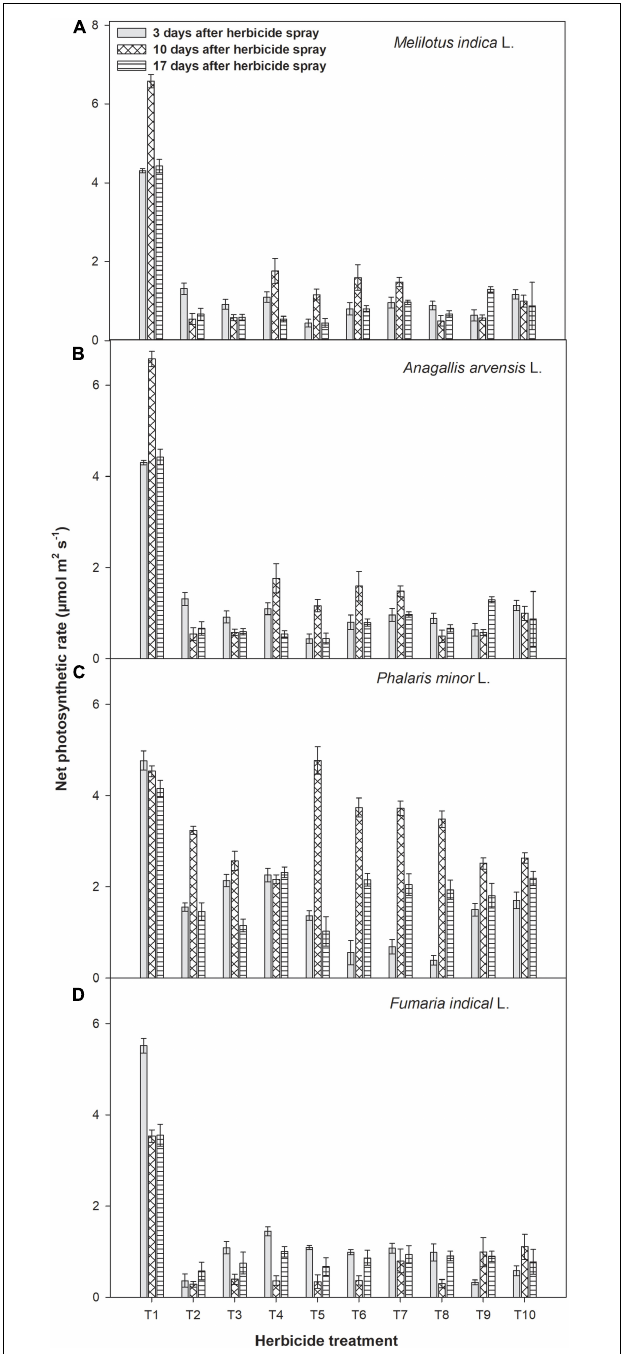
FIGURE 4 | Impact of metribuzin with and without adjuvants on stomatal conductance of Melilotus indica L. (A) , Anagallis arvensis L. (B) , Phalaris minor L. (C) , and Fumaria indica L. (D) at 3, 10, and 17 days after herbicide spray (average of 2 years’ data). T 1 , weedy check; T 2 , metribuzin at 175 g a.i. ha − 1 ; T 3 , metribuzin at 140 g a.i. ha − 1 ; T 4 , metribuzin at 105 g a.i. ha − 1 ; T 5 , metribuzin at 175 g a.i. ha − 1 + Ad-500 at 400 ml ha − 1 ; T 6 , metribuzin at 140 g a.i. ha − 1 + Ad-500 at 400 ml ha − 1 ; T 7 , metribuzin at 105 g a.i. ha − 1 + Ad-500 at 400 ml ha − 1 ; T 8 , Metribuzin at 175 g a.i. ha − 1 + Bio-power at 400 ml ha − 1 ; T 9 , metribuzin at 140 g a.i. ha − 1 + Bio-power at 400 ml ha − 1 ; T 10 , metribuzin at 105 g a.i. ha − 1 + Bio-power at 400 ml ha − 1